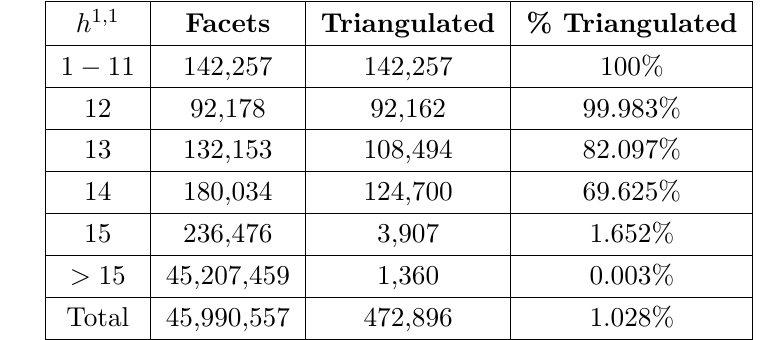
Table 1 . Dual facet FRT numbers obtained, binned by the (cid:12)rst h 1 ; 1 value at which they